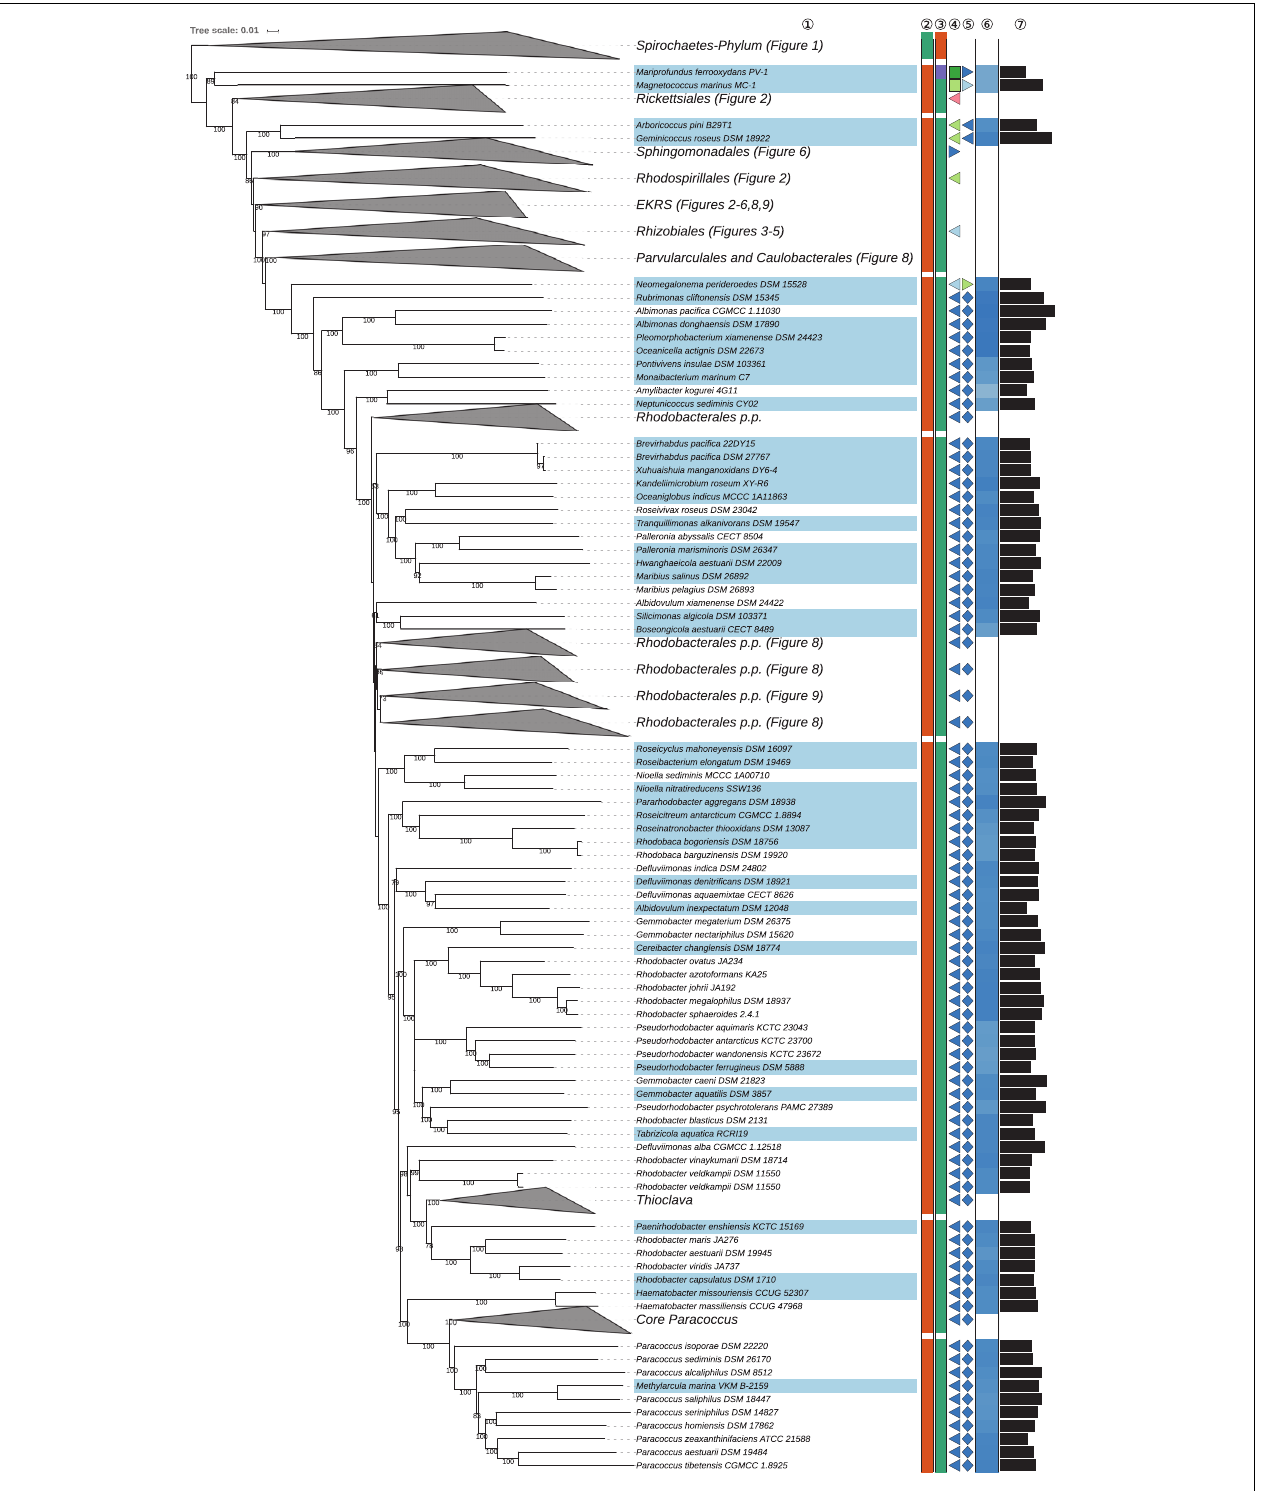
FIGURE 7 | Sixth part of the GBDP tree shown in Figure 1 , focussing on parts of Rhodobacterales . The clade labeled EKRS comprises the orders Emcibacterales, Kordiimonadales, Rhodothalassiales, and Sneathiellales , details for which are shown in other figures. Tip labels with light-blue background indicate type species of genera, colors and symbols to the right of the tips indicate, from left to right, phylum, class, order and family; for details and abbreviations see Figure 1 . The blue color gradient indicates the G+C content as calculated from the genome sequences, followed by black bars indicating the (approximate) genome size in base pairs. Rhodobacter veldkampii DSM 11550 is represented by two genome sequences (SAMN10866319, above; SAMN08535030, below).